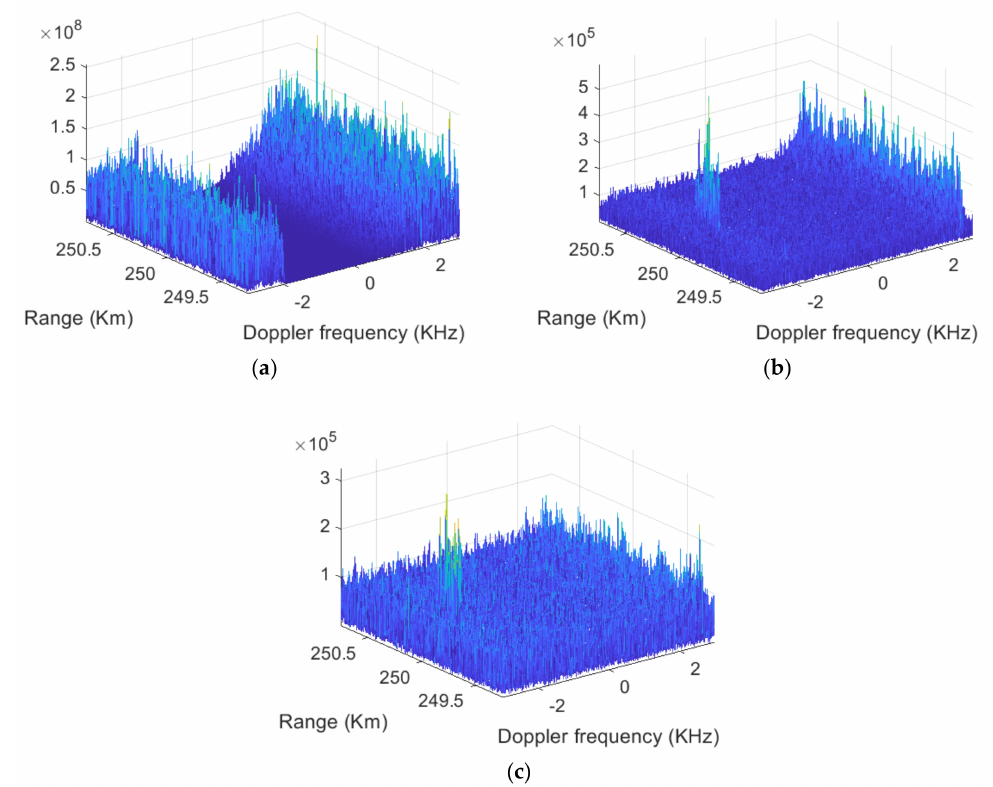
Figure 3. Simulation results of multi-resolution STAP. ( a ) Echo spectrum without clutter suppression in the R-D domain. ( b ) Full-band STAP output in the R-D domain. ( c ) Sub-band STAP output in the R-D